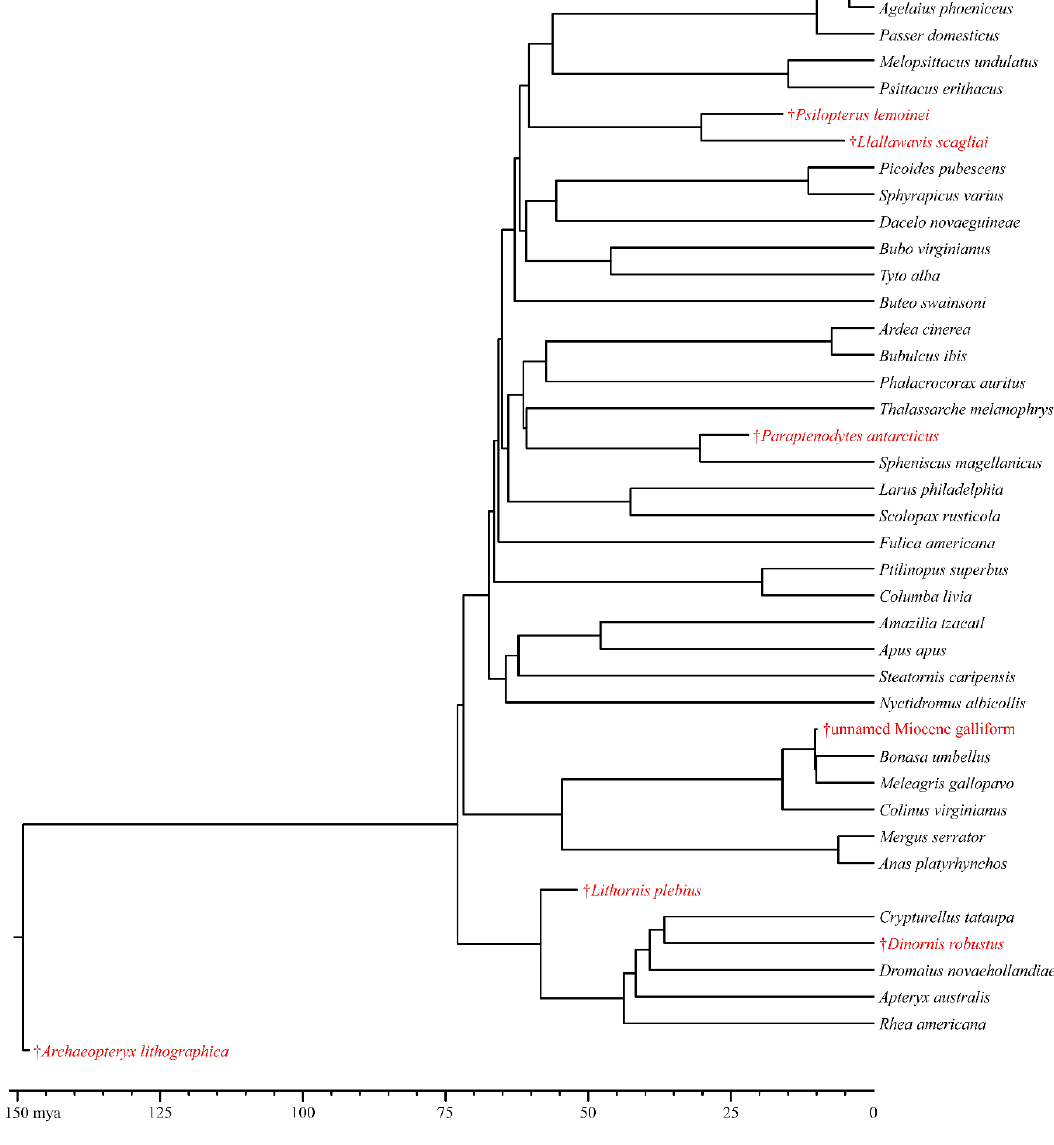
Figure 2. A phylogeny of the subset of species for which endocasts of a representative specimen were analyzed in the present study. The seven extinct birds are in red, and the timescale is in millions of years. For ease of visualization, this tree was subsampled from a tree that includes all species listed in Table S1. That tree is a composite of the backbone of Prum et al. [60] and the finer-level topology of Jetz et al. [61]. The complete tre file, which includes divergence time estimates, is available in the Supplementary Materials (S4).